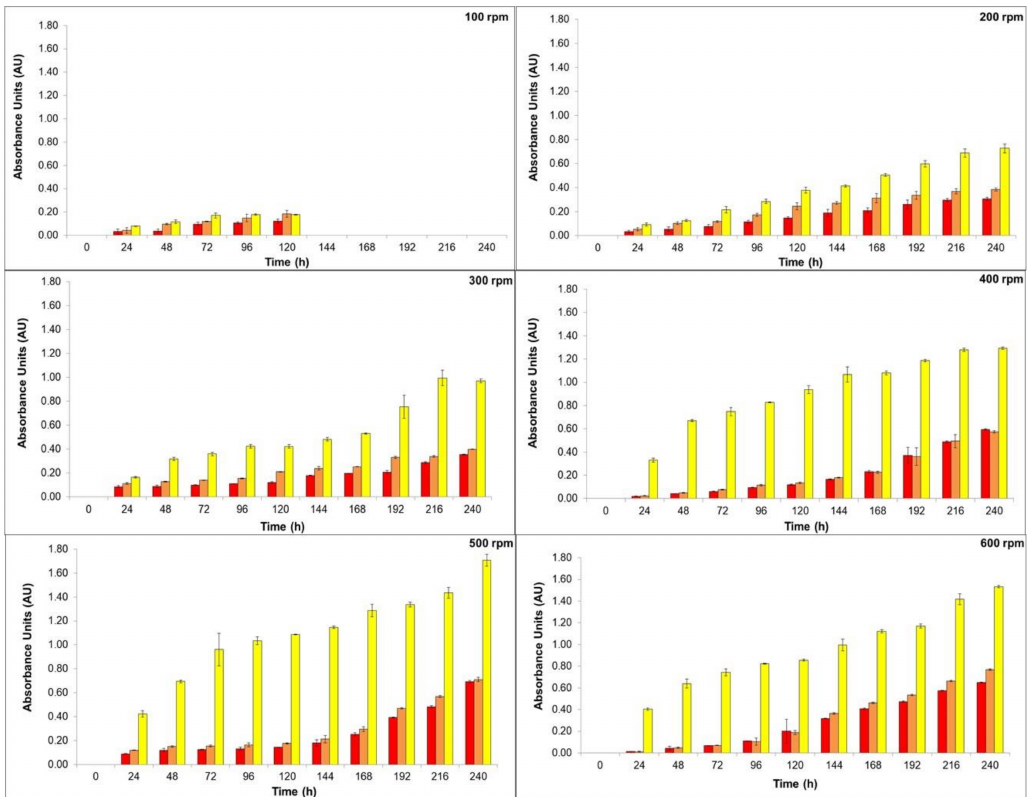
Figure 1. Production of yellow (yellow bars), orange (orange bars), and red colorants (red bars) by submerged culture of T. amestolkiae in stirred-tank bioreactor at 2.0 vvm and 30 ◦ C by varying the stirring speed (100 to 600 rpm) as a function of time (0 to 240 h). The error bars represent 95% confidence levels for the mean of three independent